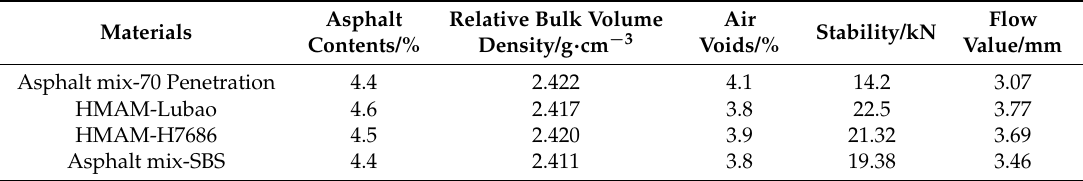
Table 6. The properties of asphalt mixtures.